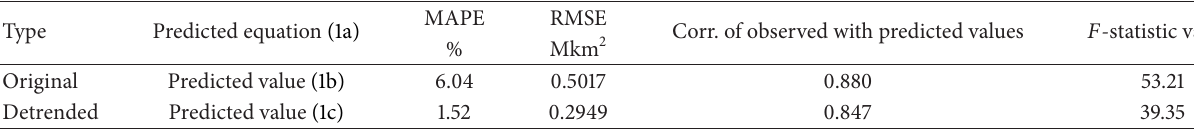
Table 4: Statistical analyses for the simple forecasting models from (1a); mean absolute percentage error (MAPE) and root mean squared error (RMSE) from (3a) and (3b) are two indictors used to show the feature of the prediction error for Arctic sea ice in September. The critical value of 𝐹 -test ( 𝐹 𝛼= 0 . 01 ) for (1a) is